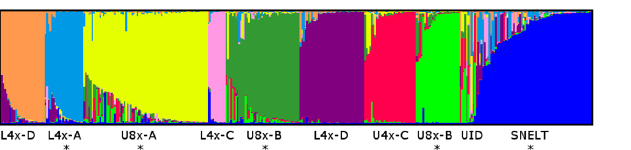
Fig 2. STRUCTURE analysis of SSR markers from all switchgrass cultivars and collected plants (n = 365). Individuals are shown as a vertical line representing the membership fractions for each of the K populations and sorted according to q-value (K = 9). Switchgrass lineages abbreviated as shown in [42]. Other abbreviation: Southern New England Lowland Tetraploid, SNELT; UID, Unidentified. Genotype groups with an asterisk ( * ) include one or more individuals collected from the LISCL coastal ecoregion or inland road verges.